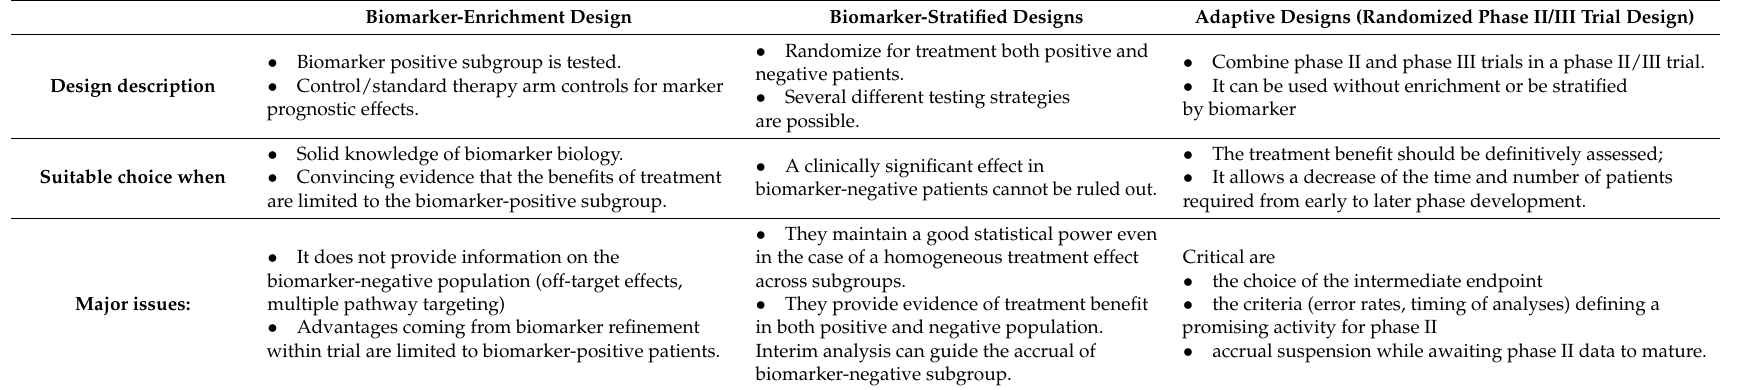
Table 3. Biomarkers